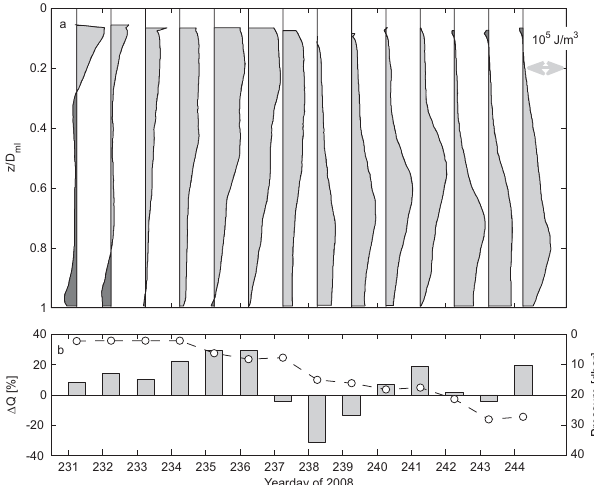
Fig. 12. (a) Change in total mixed layer heat content within con- secutive 24-h intervals (bars) and net vertical heat fluxes into the mixed layer (thick line). (b) Contribution of net ice fluxes to the to- tal change in mixed layer heat content. Horizontal lines are averages for the two periods before and after doy